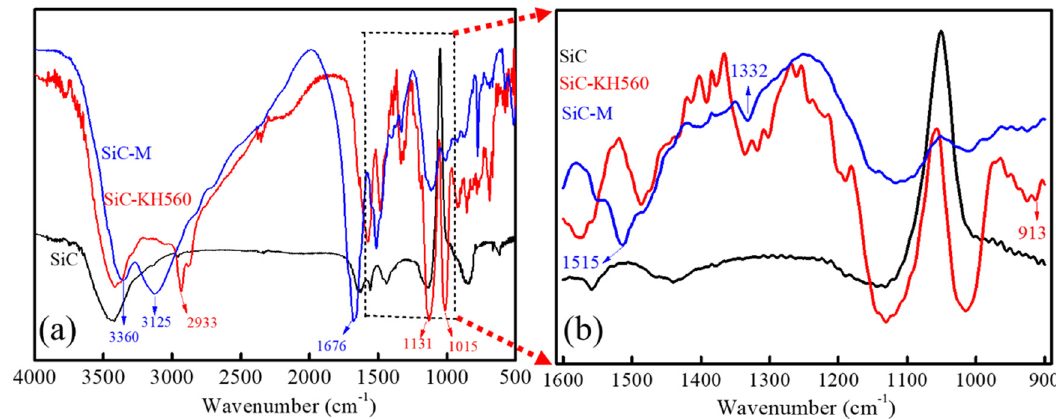
Figure 1: IR spectrum of SiC, SiC - KH - 560, and SiC - M; ( a ) original curve picture, ( b ) partial enlarged view of picture ( a )